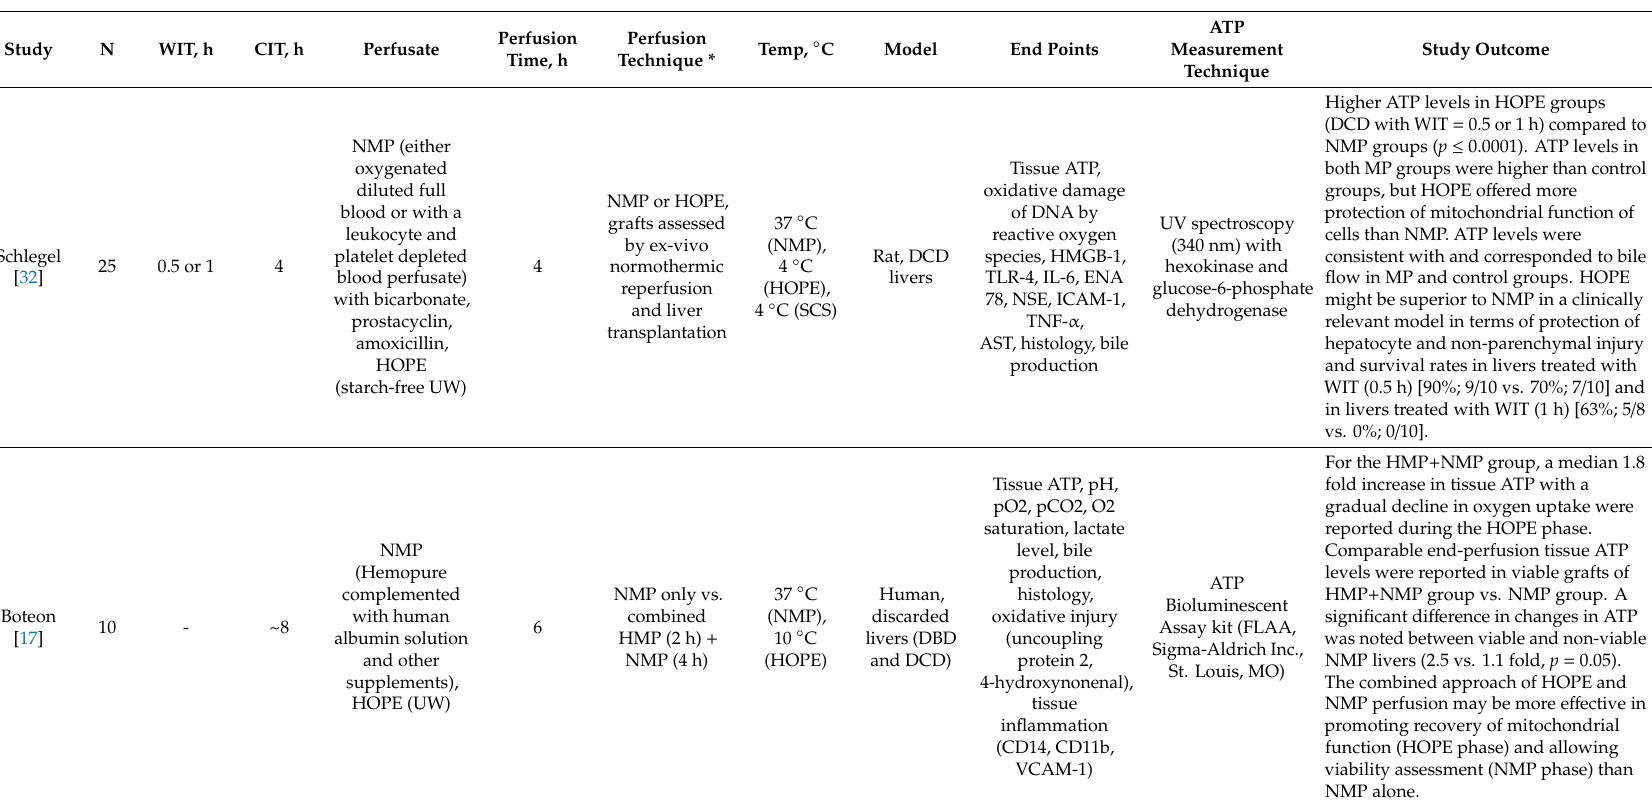
Table 6. Characteristics and outcomes of key pre-clinical and animal studies comparing HMP versus NMP or combined approach (HMP + NMP) preservations of liver.